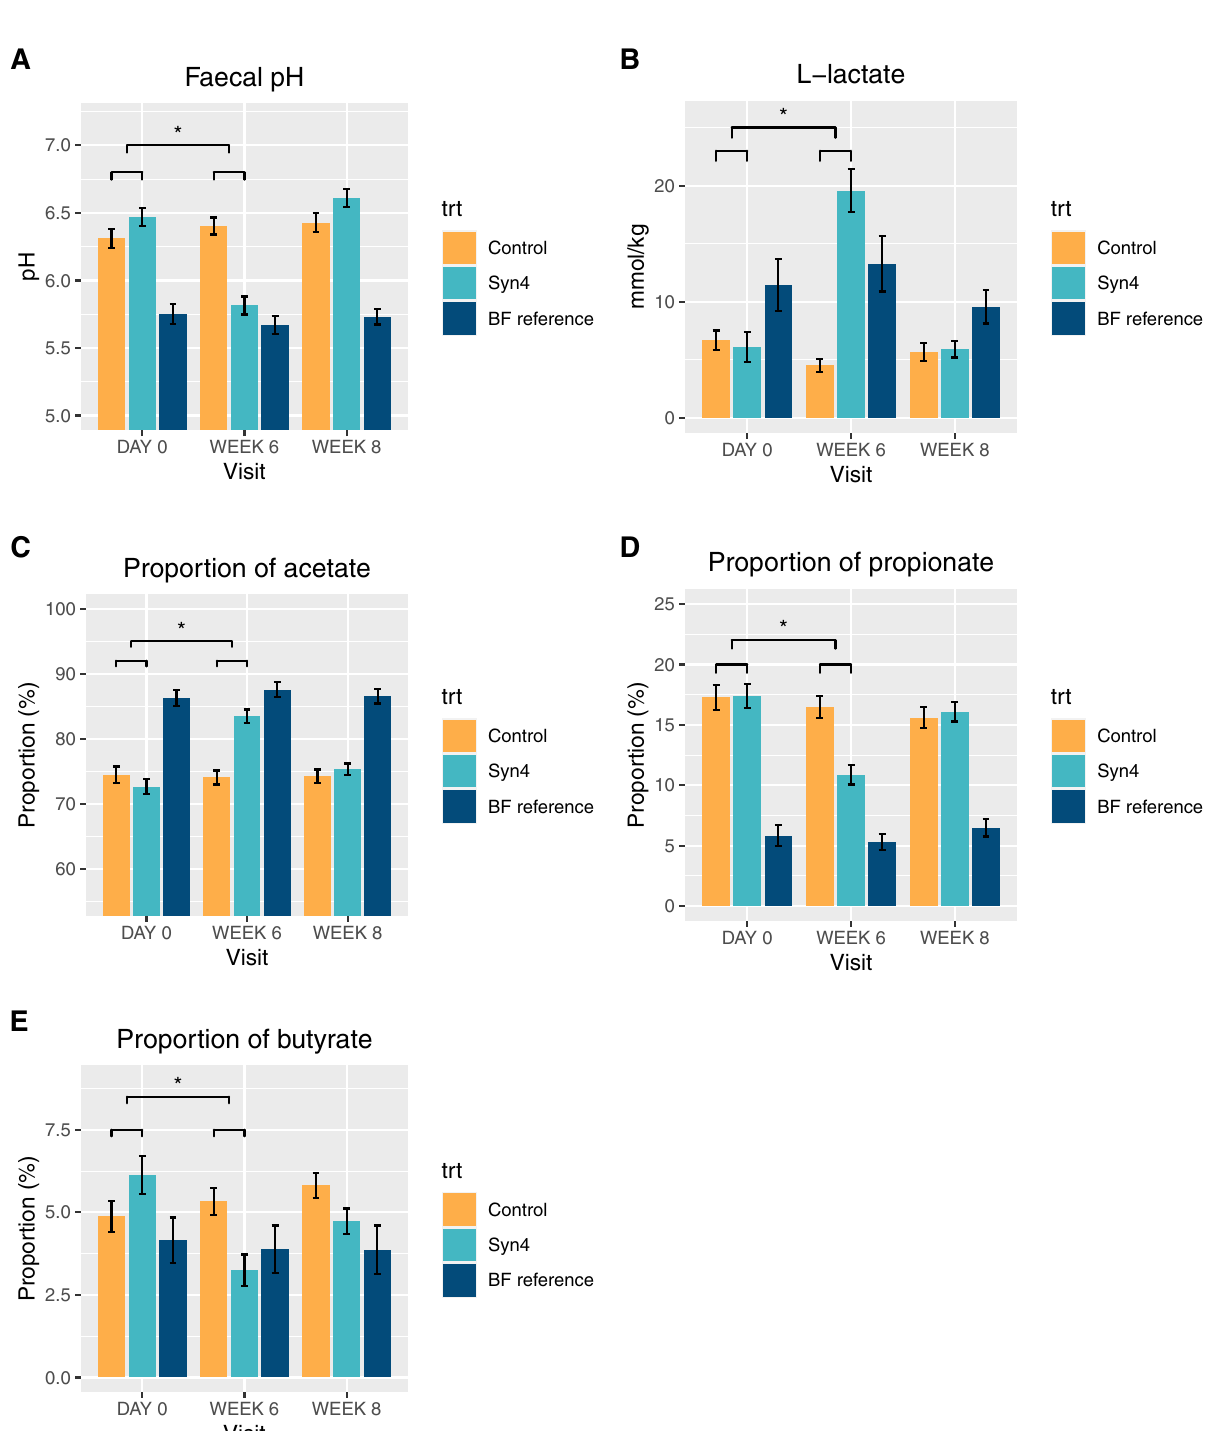
Figure 5. The Syn4 dose resulted in a significantly larger decrease in pH ( A ) and a significantly larger increase in the l-lactate concentration ( B ) and the proportion of acetate ( C ) as compared to control. The proportion of propionate ( D ) and butyrate ( E ) in the Syn4 arm decreased significantly more from baseline as compared to the control arm. Data are expressed as mean ± SE. *Statistically significant differences in change from baseline between treatment groups (p-value < 0.05) as assessed by a longitudinal linear mixed-effect model with intervention, time, study site as fixed factors, intervention by time as interaction term and subject as a random